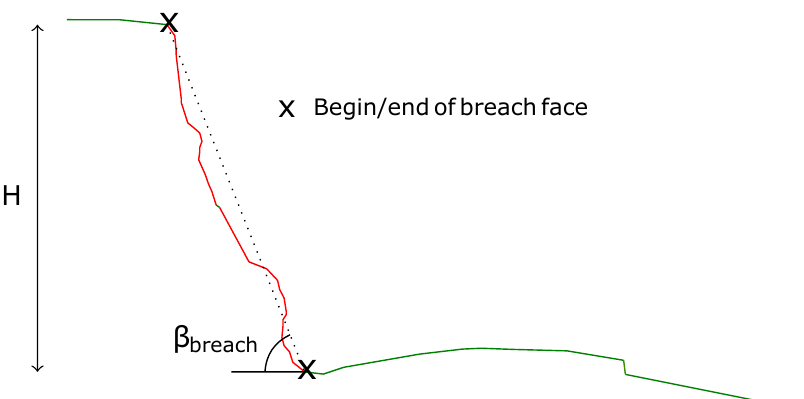
Figure 8. Definitions used for the breach height, H , and breach face angle, β breach .